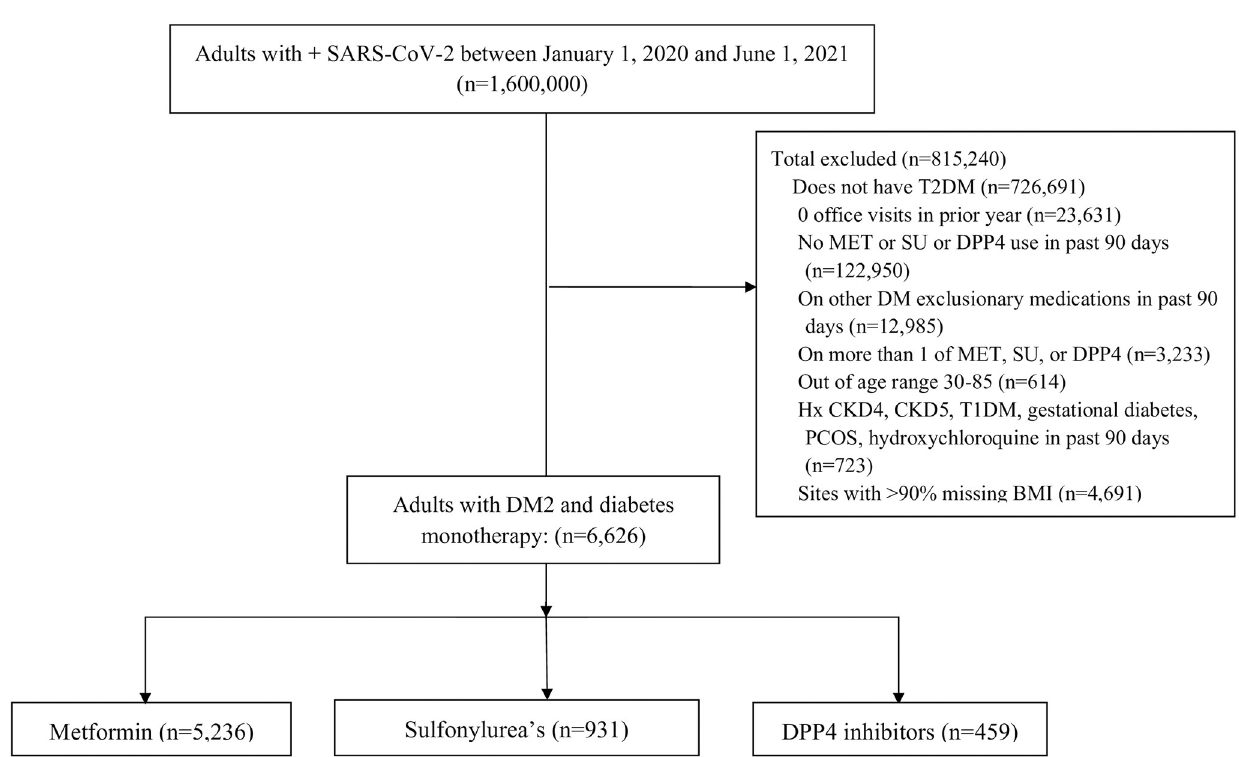
Fig 1. This represents the number of patients included in the analysis after the inclusion and exclusion criteria were